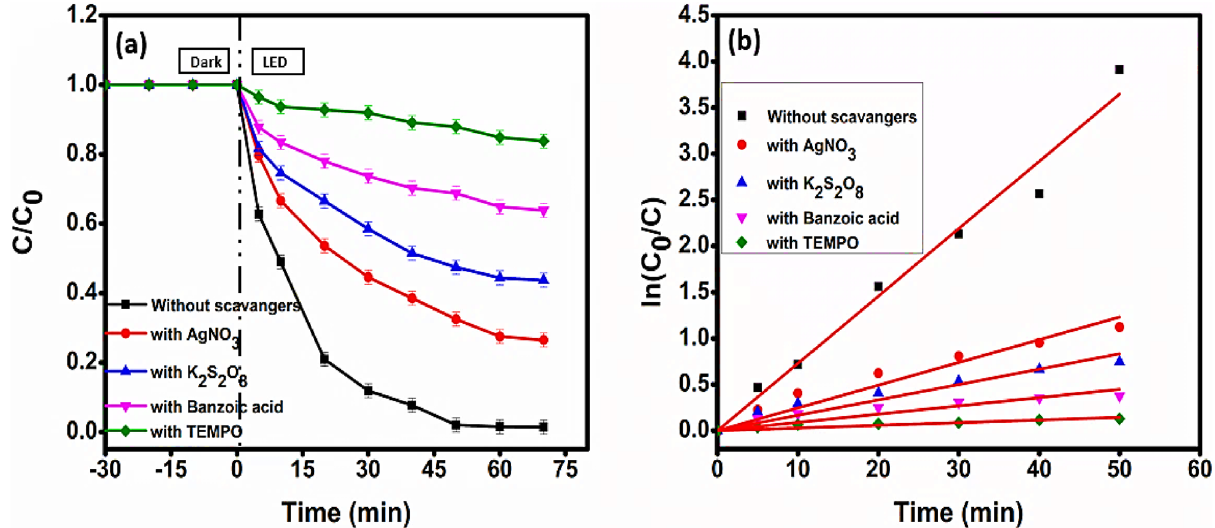
Figure 16. ( a ) Degradation profile and ( b ) kinetics plot for scavenger experiment for MG dye degradation with photocatalyst CMCu.